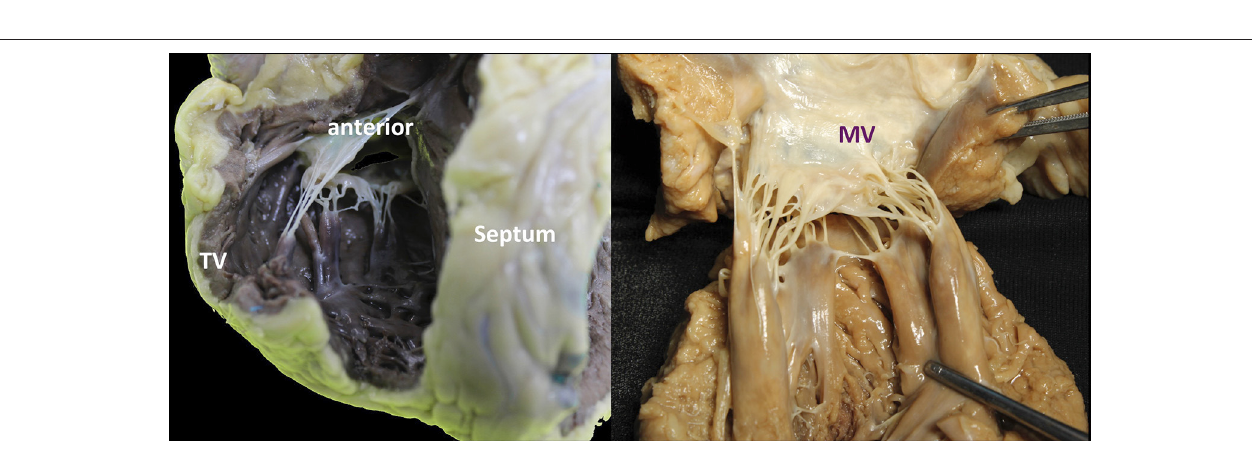
FIGURE 7 | Comparison of mitral and tricuspid PMs. (A,B ) Each group of papillary muscles comprises either a single bulky papillary with multiple heads or otherwise several thinner papillary muscles from which arise the numerous chordae attaching to the leaflets. They are implanted on the muscular wall of the left ventricle at a junction situated ∼ 1/3 from the apex and 2/3 from the annulus. The position is varying little: the anterolateral PM is implanted at the junction between the septum and the posterior wall of the ventricle. The postero-medial PM is inserted on the lateral wall of the ventricle. The length of the PMs is variable, ranging from 2 to 5cm. Importantly, no PMs attach to the left side of the ventricular